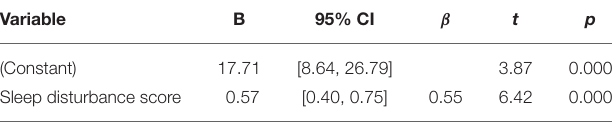
TABLE 1 | Participants nocturnal sleep duration. TABLE 2 | Regression analysis for sleep disturbance and anxiety.